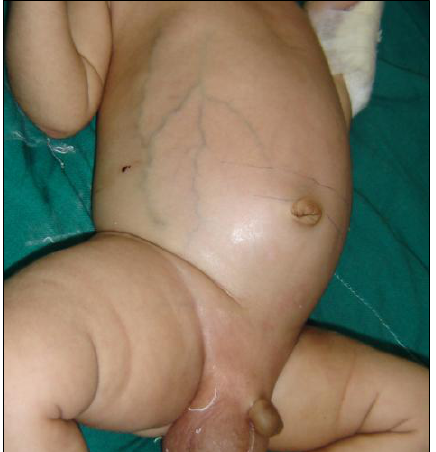
Figure 1: Leg deformity and ipsilateral scrotal